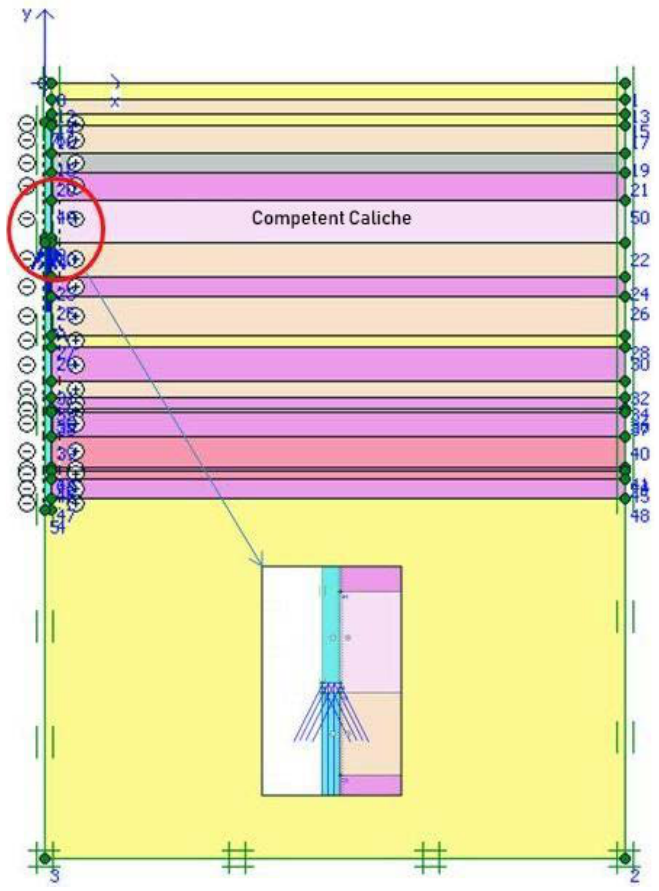
Figure 10. Finite element simulation based on the reported bidirectional test results, Case Study II.